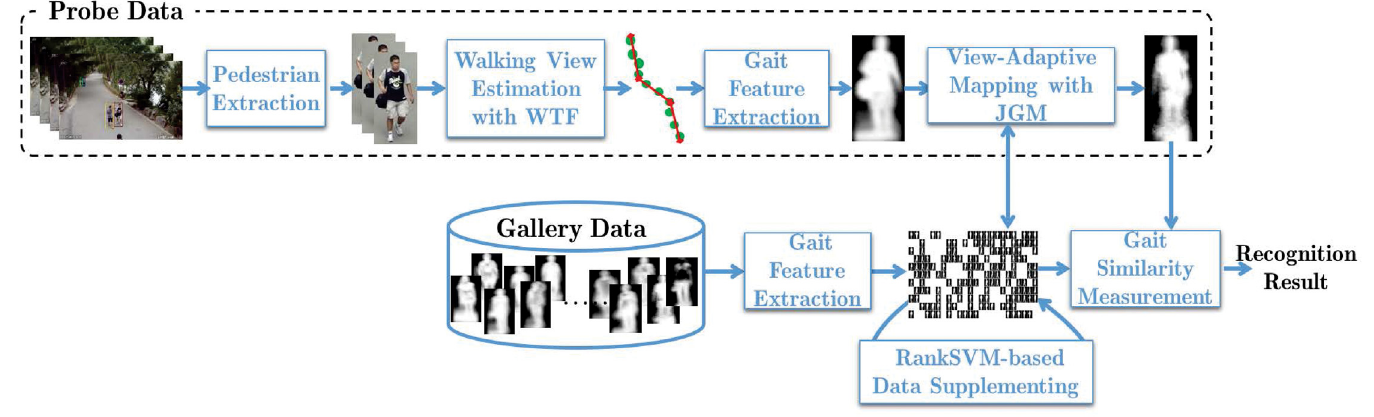
Fig 2. The framework of our proposed view-adaptive mapping (VAM) technique for free-view gait recognition.